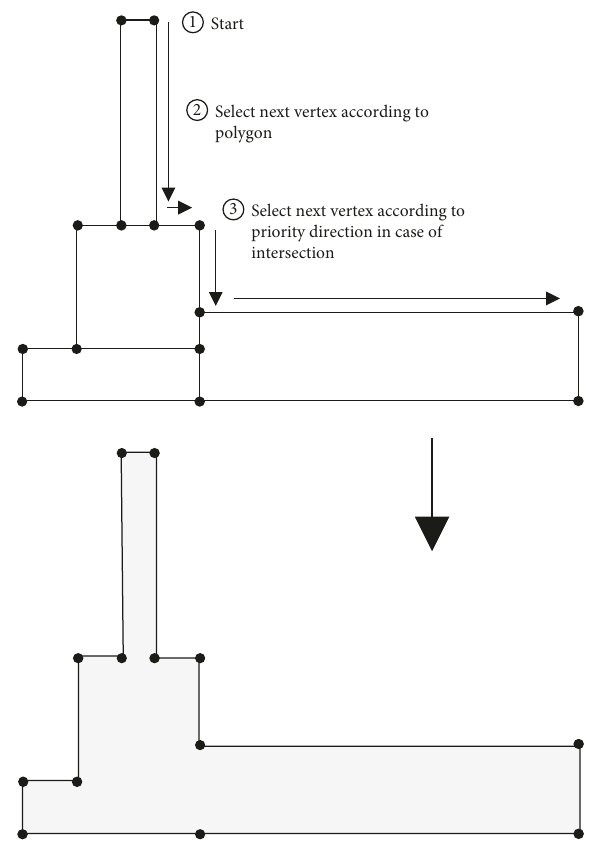
Figure 6: Boundary extraction